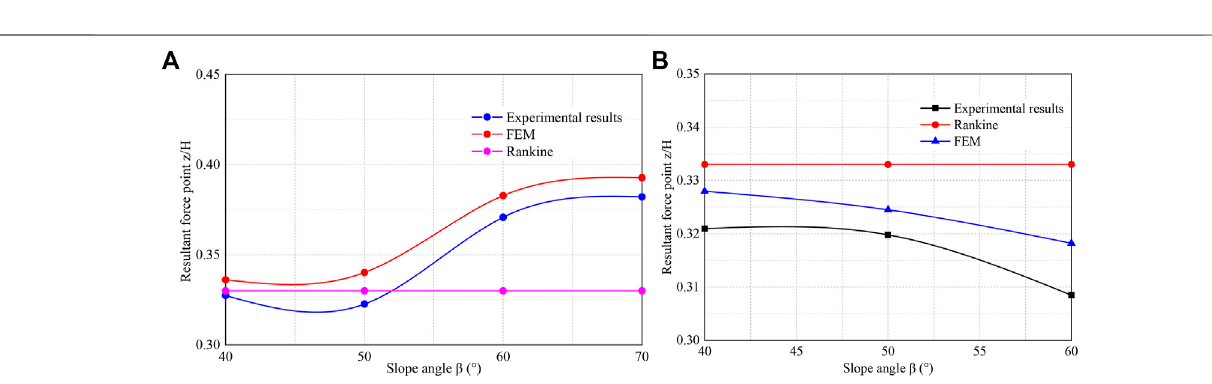
Frontiers in Earth Science |